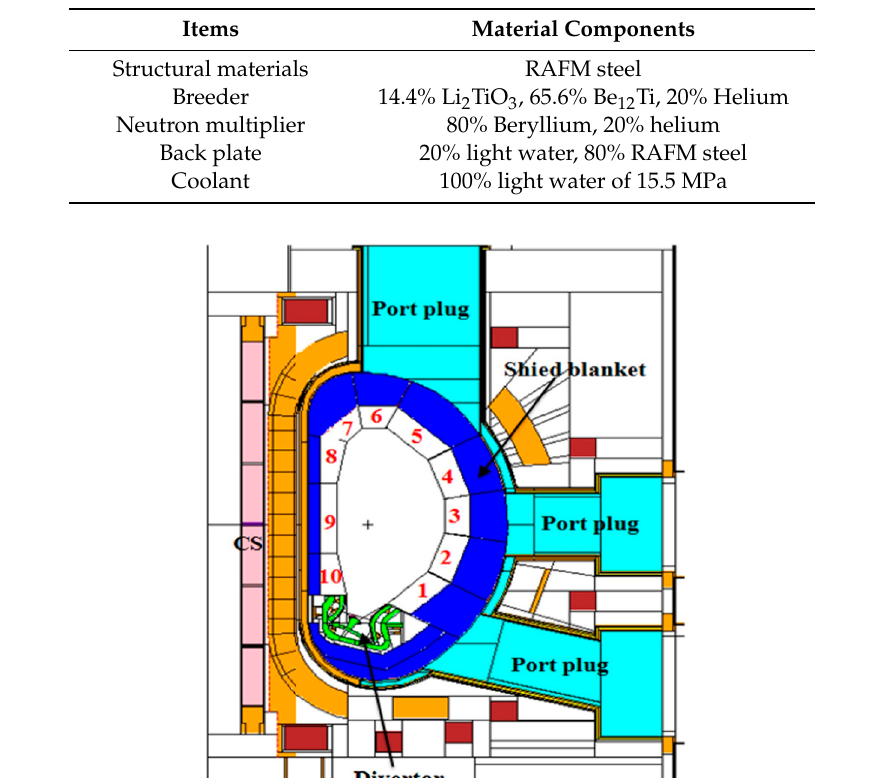
Table 6. Material selections of the WCCB blanket.